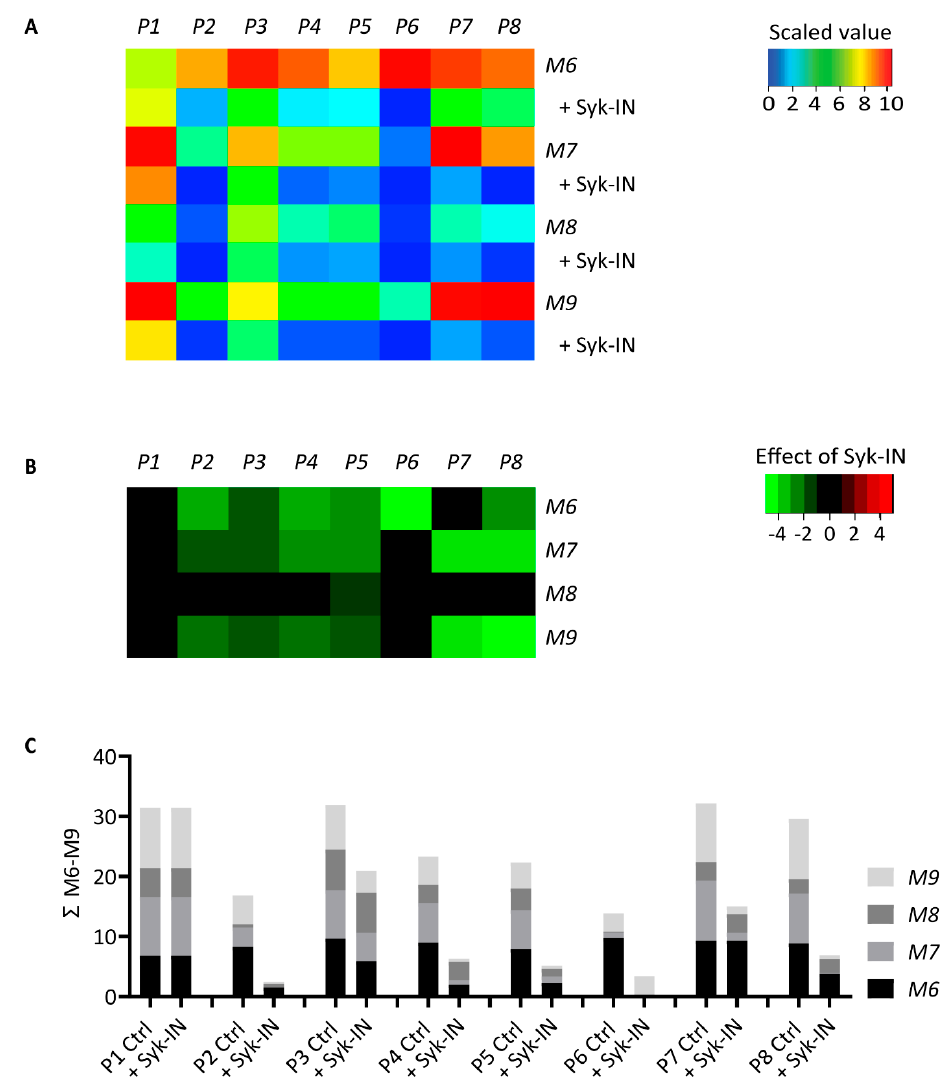
Figure 6. E ff ect of Syk inhibition on parameters of thrombus formation on immobilized collagen. Whole blood pre-incubated with vehicle (Ctrl) or Syk-IN (20 µ M) was perfused over microspots M6–9, and thrombus formation was imaged to obtain parameters P1–8, as in Figure 5. The e ff ects of Syk-IN were calculated per blood sample, surface, and parameter. Mean values for all blood samples ( n = 5–7) were univariate-scaled to 0–10 per parameter across all surfaces of M1–9. ( A ) A heatmap of the scaled parameters showing the mean e ff ects of Syk-IN. The rainbow color code gives scaled values between 0 (blue) and 10 (red). ( B ) A subtraction heatmap representing the scaled e ff ects of Syk-IN, filtered for relevant changes ( p < 0.05, paired Student’s t -tests per surface and parameter). The color code represents decreases (green) or increases (red) in comparison to control runs. ( C ) Cumulative inhibitory e ff ect over all microspots per parameter, indicating relevant changes from control